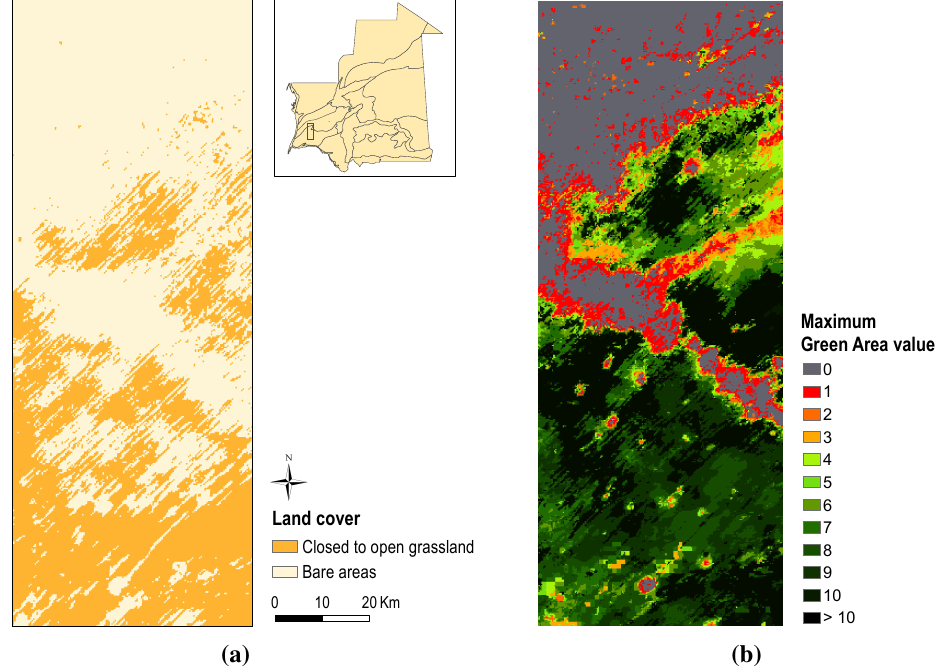
Figure 8. Characteristics of the studied area. (a) Land occupation (source: GlobCover 2009). (b) Maximum values of green area from 1 June 2010–31 May